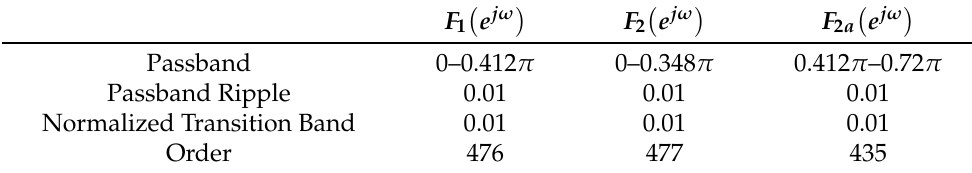
Table 2. Key specifications for digital anti-alias filter in classical